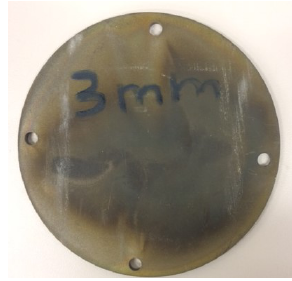
Figure 10. Steel disc sample of 3 mm thickness, 100 mm diameter.